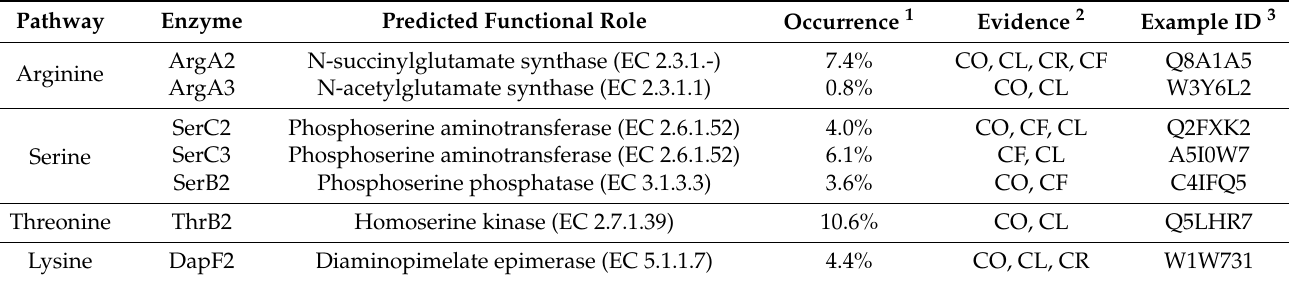
Table 2. Novel amino acid biosynthesis enzymes predicted as non-orthologous gene displacements in HGM